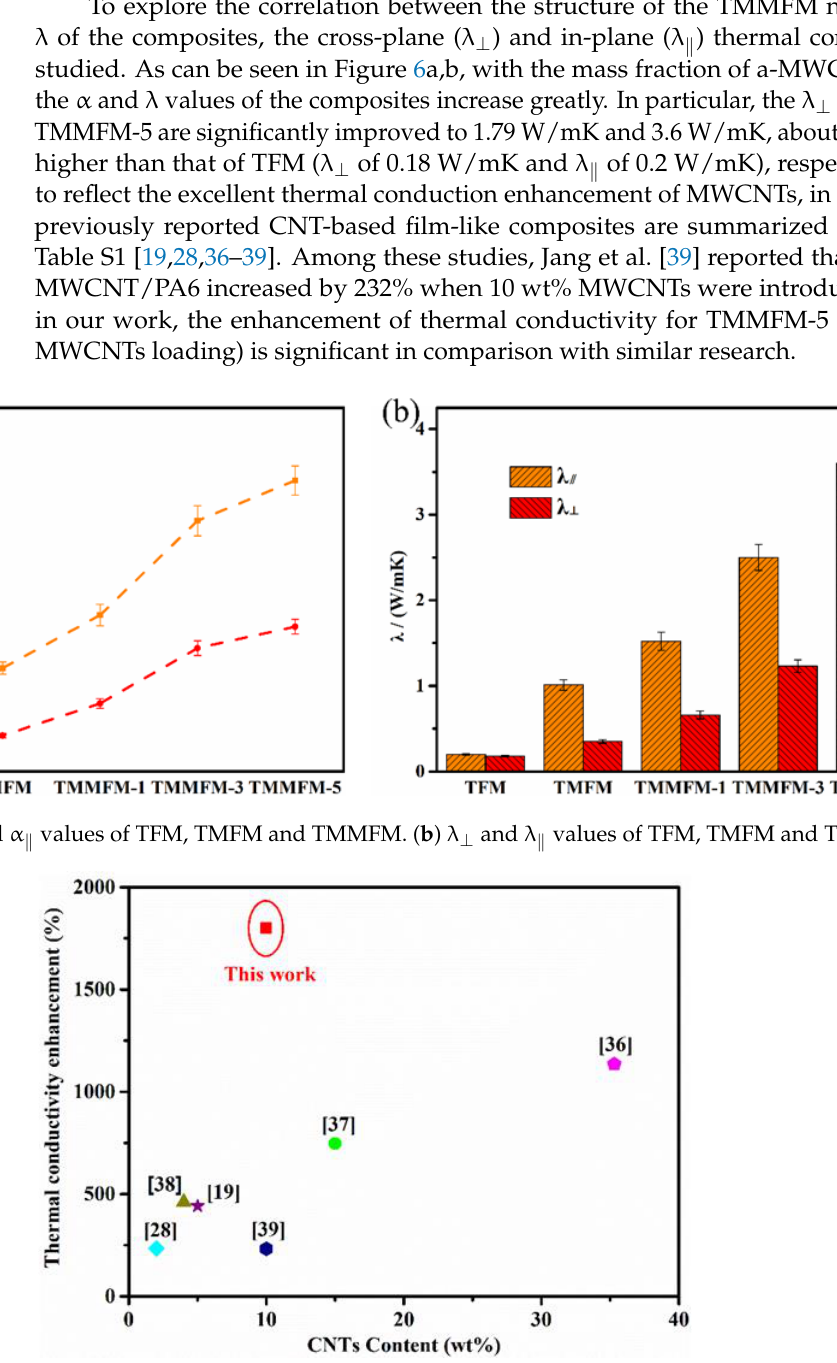
Figure 7. Thermal conductivity enhancement of this work comparison with others.